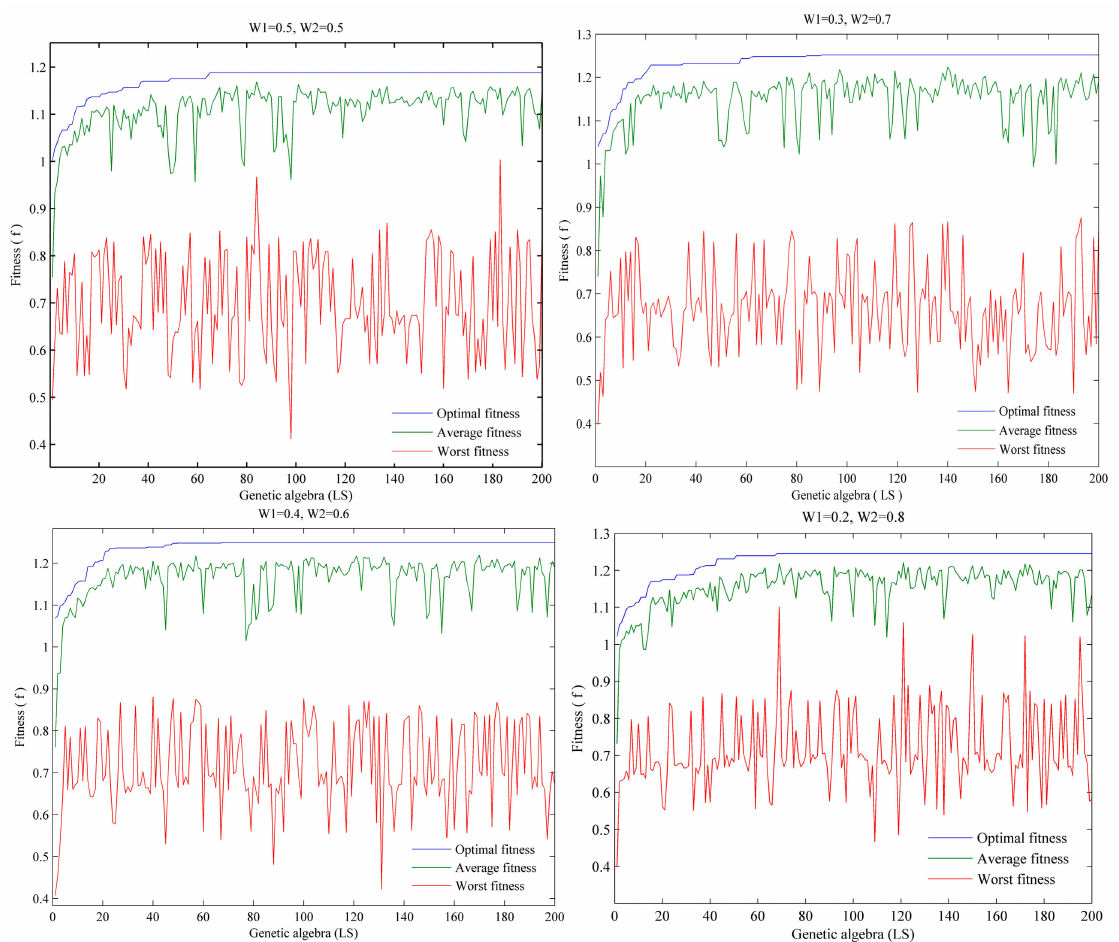
Figure 7. The convergence of the hybrid genetic algorithm (HGA) under different objective